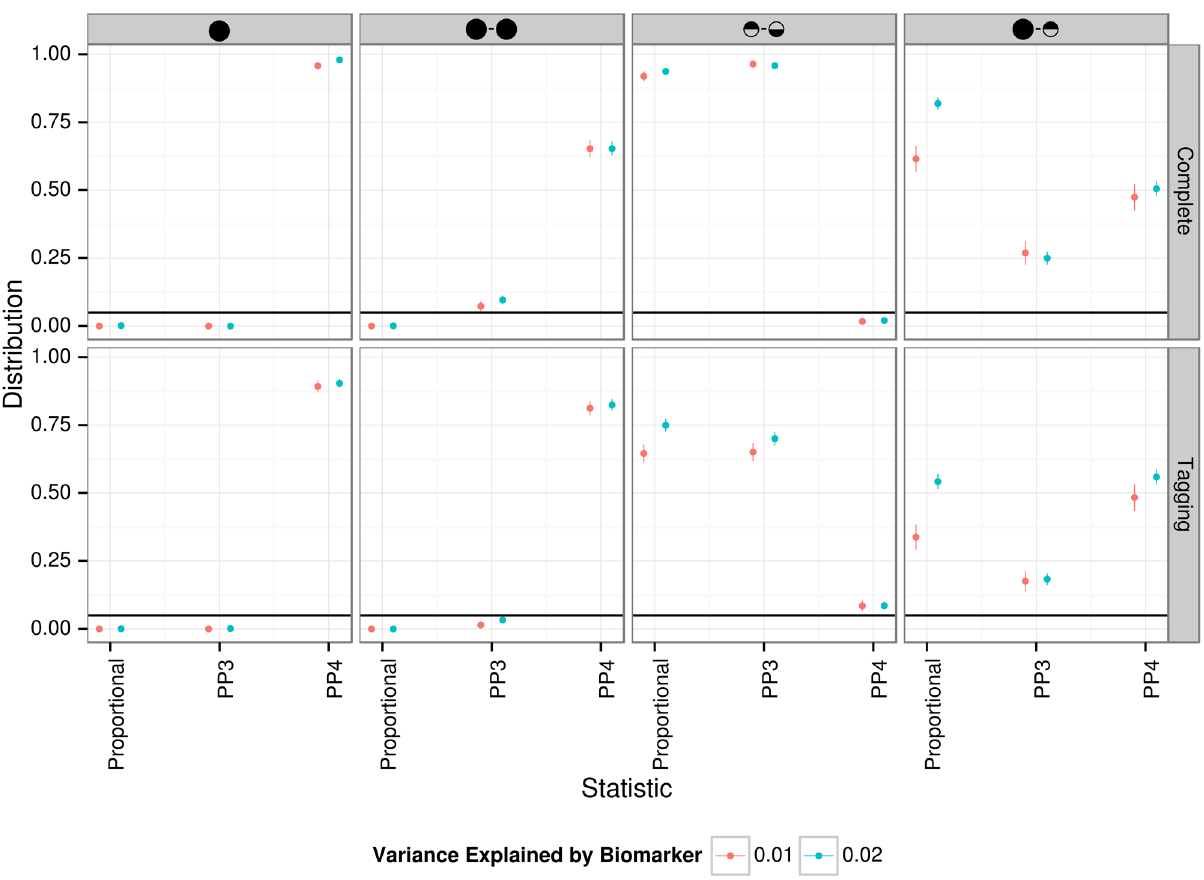
Figure 5. Summary of proportional and Bayesian colocalisation analysis of simulated data. Each plot shows a different scenario, the total number of causal variants in a region is indicated by number of circles in the plot titles with causal variants affecting both traits, the eQTL trait only, or the biomarker trait only, indicated by full circles, top-shaded circles and bottom-shaded circles respectively. In the top row the causal variant is typed or imputed, whereas only tag variants are typed/imputed in the bottom row. For proportional testing (under the BMA approach), we show the proportion of simulations with posterior predictive p-value , 0.05 (black horizontal line) while for our Bayesian analysis we plot the proportion of simulations with the posterior probability (PP3 or PP4) of the indicated hypothesis . 0.9. Error bars show 95% confidence intervals (estimated based on an average of 1,000 simulations per scenario). In all cases, for the eQTL sample size is 1,000; genetic variants explain a total of 10% of eQTL variance; for the biomarker trait, the sample size is 10,000.